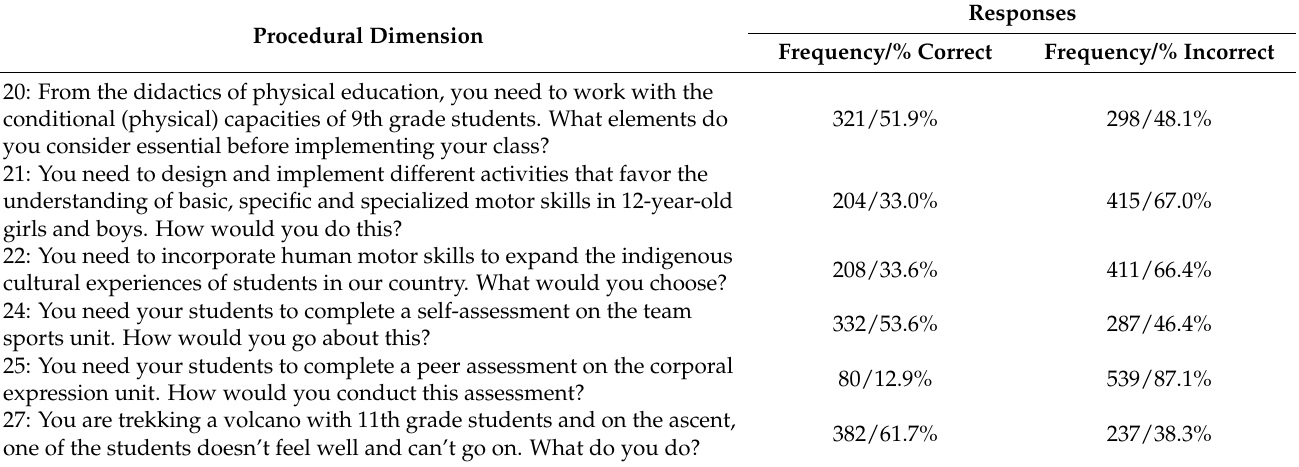
Table 4. Descriptive results for the procedural dimension.